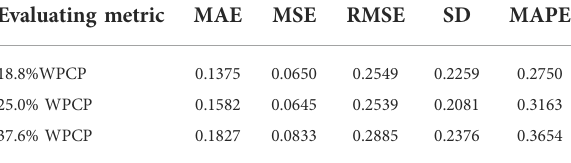
TABLE 4 Performance metrics in scenario